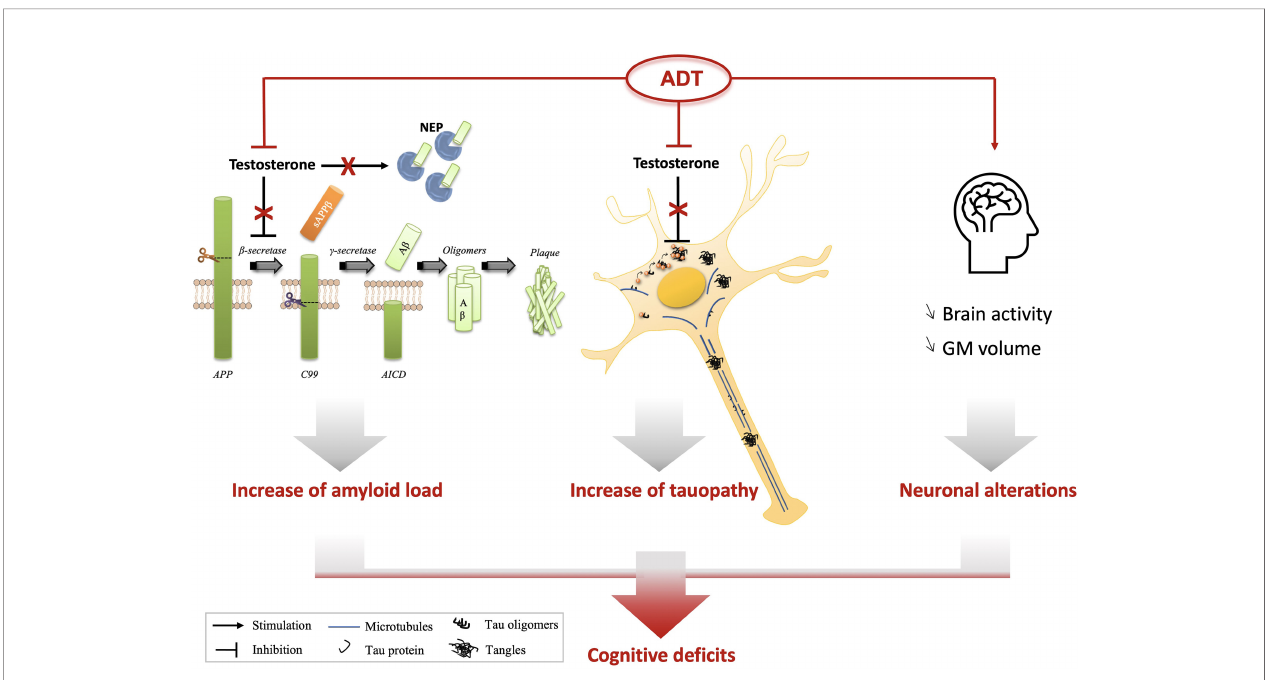
FIGURE 1 | Possible connections between ADT and cognitive decline. Thanks to preclinical studies based on androgen deprivation or testosterone supplementation, it has been suggested that testosterone depletion could play a direct role on A b accumulation through the modulation of its production [activation of the b -secretase (BACE1)] or its degradation (reduction of neprilysin (NEP) expression and activity). Androgen deprivation also led to a decrease of hyperphosphorylation of Tau proteins (p-Tau) and their accumulation in neurons. In patients, ADT has been shown to induce a decrease of grey matter (GM) volume and a reduced brain connectivity using imaging, two characteristics also observed in AD brains. A b accumulation or p-Tau increase have been associated with a reduction of cognitive performances of animals, suggesting that ADT directly in fl uences amyloid and tau levels, in addition to neuronal activity which could lead to cognitive decline of patients. APP, Amyloid Precursor Protein; AICD, APP Intracellular